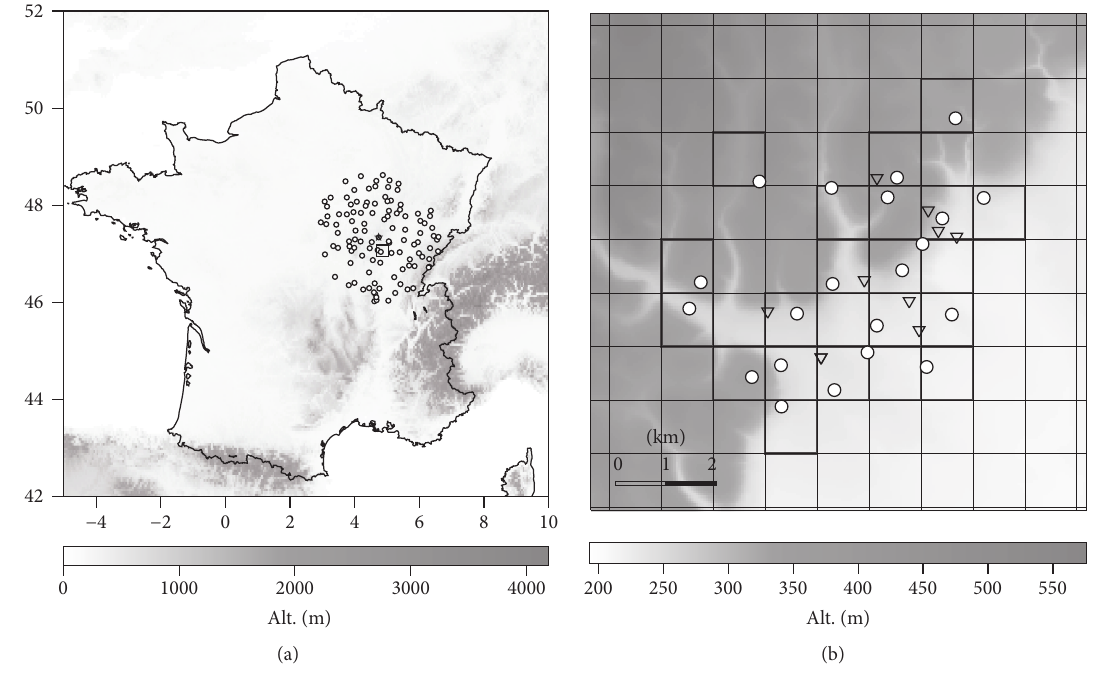
Figure 1: The mesoscale and local scale rain gauge network. (a) The star indicates the radar position. Small circles indicate the location of MFRN rain gauges located less than 150 km from the radar. The square indicates the position of the HydraVitis network. (b) White circles indicate the location of the rain gauges providing the HydraVitis data used in this study. The bold gridlines show the boundaries of the 1km 2 radar pixels in which a rain gauge was available for comparison.